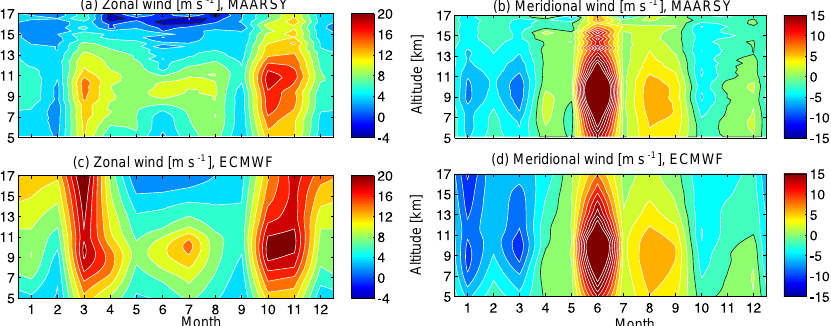
Figure 3. Seasonal variations in monthly-mean wind velocity for a composite year derived from MAARSY (a, b) and the ECMWF reanalysis data (c, d) based on identical sampling between both zonal winds in the left panels and meridional winds in the right panels. The zero-velocity contours are indicated in black and the white contours in a step of 2ms − 1 . Positive values are for eastward and northward